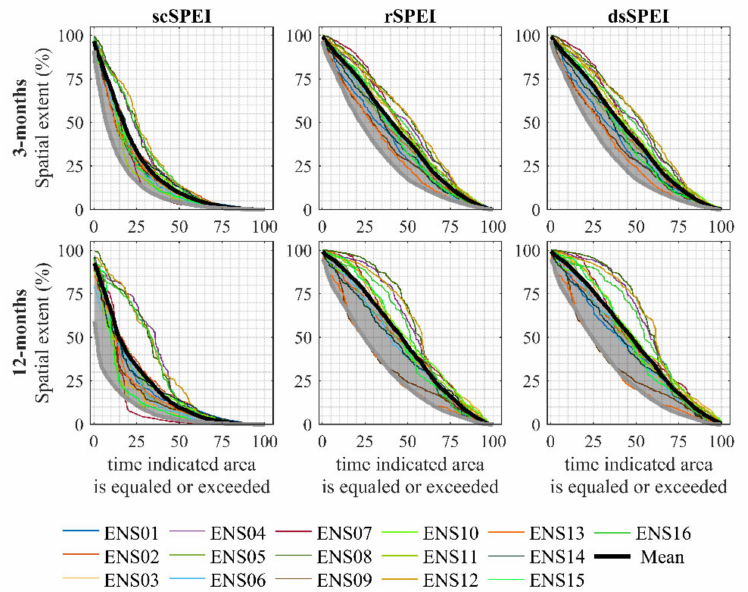
Figure 8. Areal extension-duration curves for all ensemble members and the ensemble mean for the near future. The timescales are displayed in rows and the different methods in columns. The gray line indicates the ensemble mean for the recent past. The grey-shaded areas represent the difference between the ensemble mean of the two different